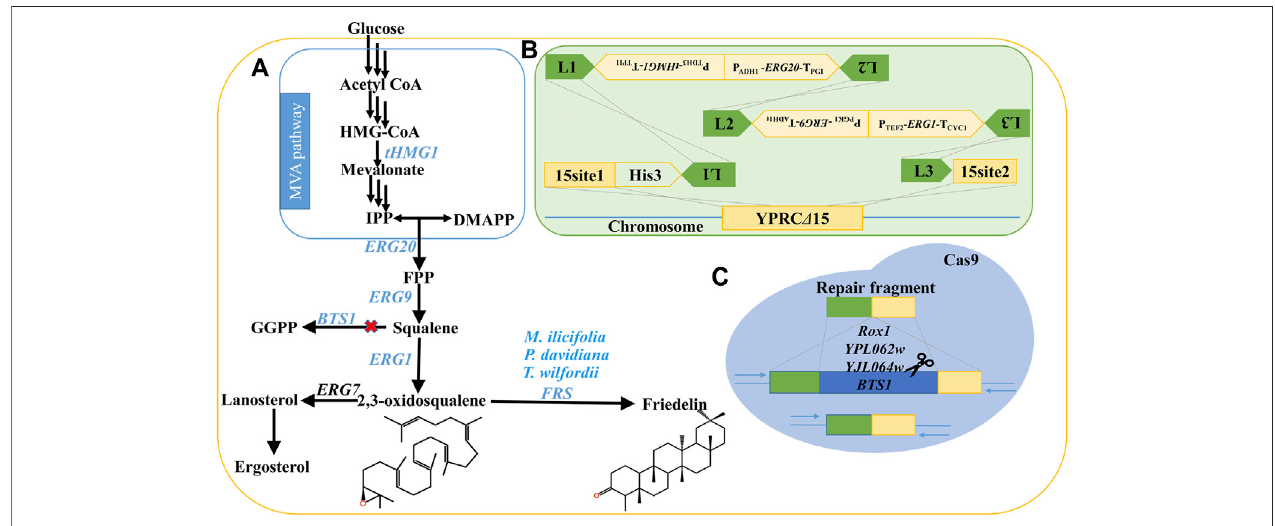
FIGURE 2 | Strategies employed to enhance the production of friedelin in S. cerevisiae . (A) The biosynthesis pathway of friedelin in S. cerevisiae . (B) Key genes ( tHMG1 , ERG20 , ERG9 , ERG1 ) of the MVA pathway were integrated into the genome of BY4741 to increase the metabolic fl ux of precursor 2,3-oxidosqualene. (C) Knock out genes affecting the MVA pathway by CRISPR/Cas9 technology, including BTS1 , ROX1 , YPL062w and YJL064w . The red X represents blocking. IPP: isopentenyl diphosphate; FPP: farnesyl diphosphate; GGPP: ( E , E , E )-geranylgeranyl diphosphate; FRS: friedelin